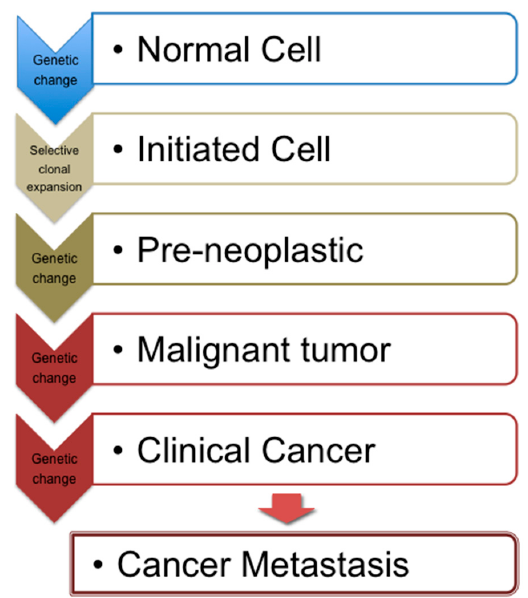
Figure 1. Schematic depiction of cancer development/progression.